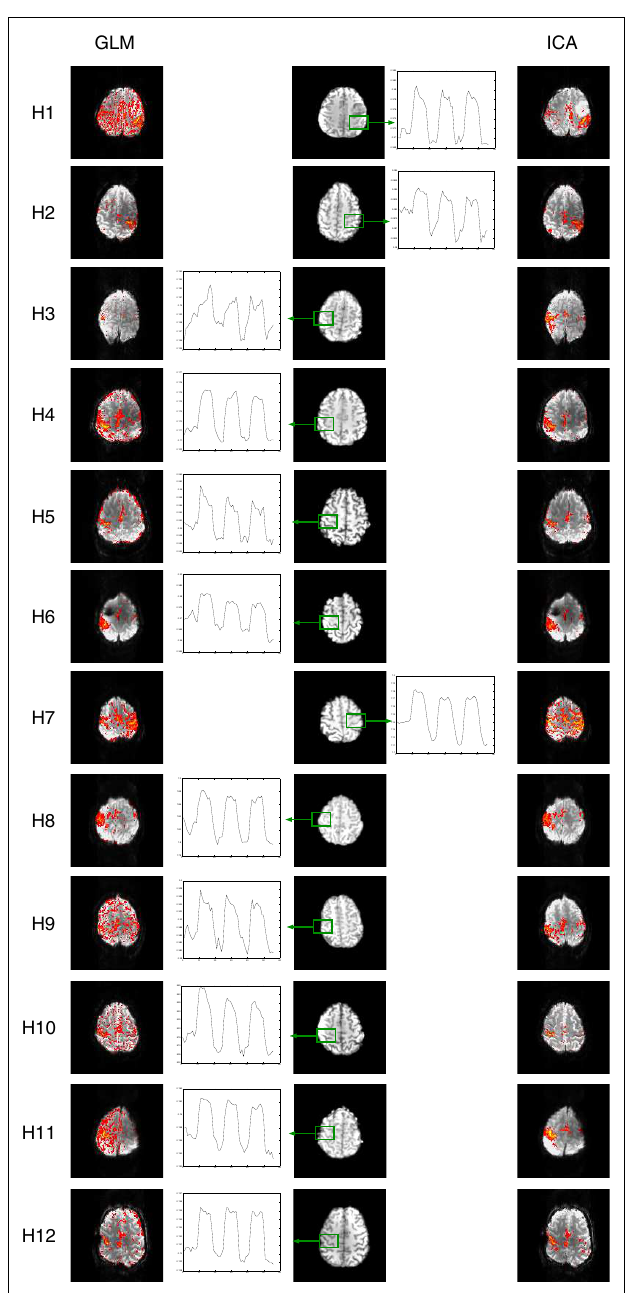
FIGURE 7 | Mean responses in voxels in primary motor areas in the hand task .Time courses in PMA in C2 and C3 (outlined in red) are non-model-conform, and correspond with low sensitivity in GLM results (left) but not ICA (right).